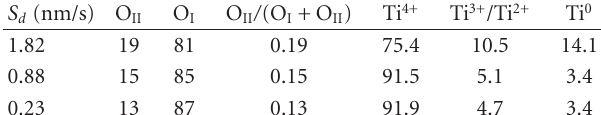
Table 4: Relative contributions (%) to the Ti 2p XPS lines from the di ff erent oxidation states for TiO 2 − y thin films deposited by the reactive sputtering.